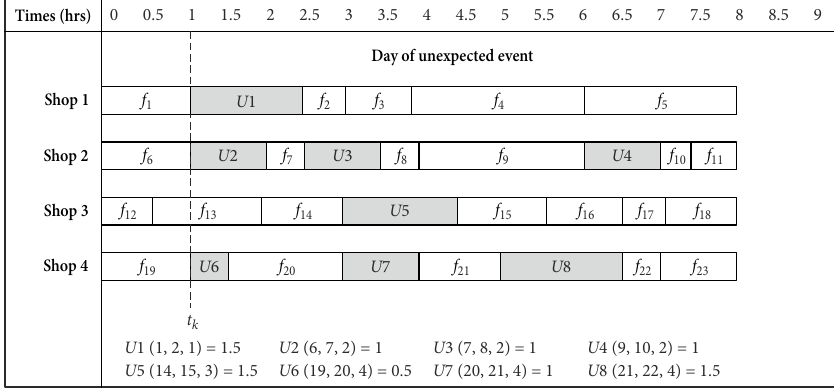
Figure 9. Untapped ranges between the pre-established regular failures schedules